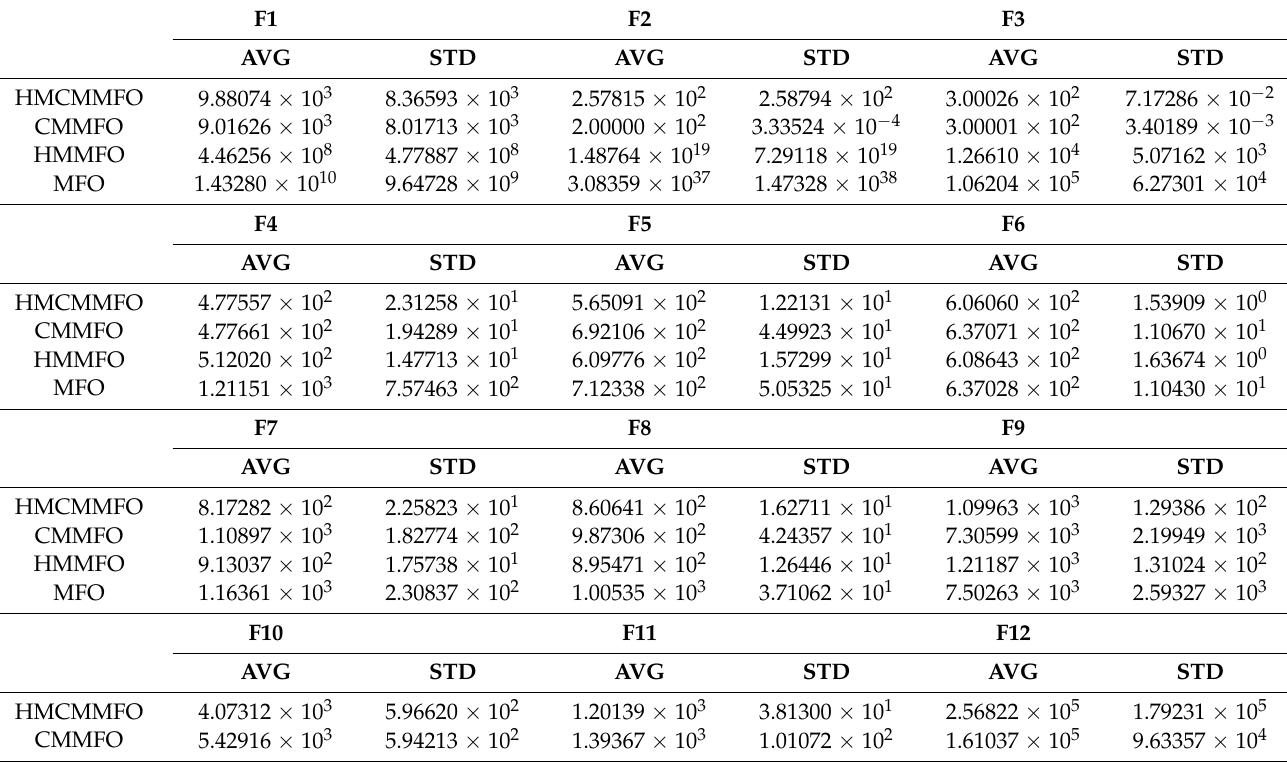
Table 5. Comparison of MFO results with different